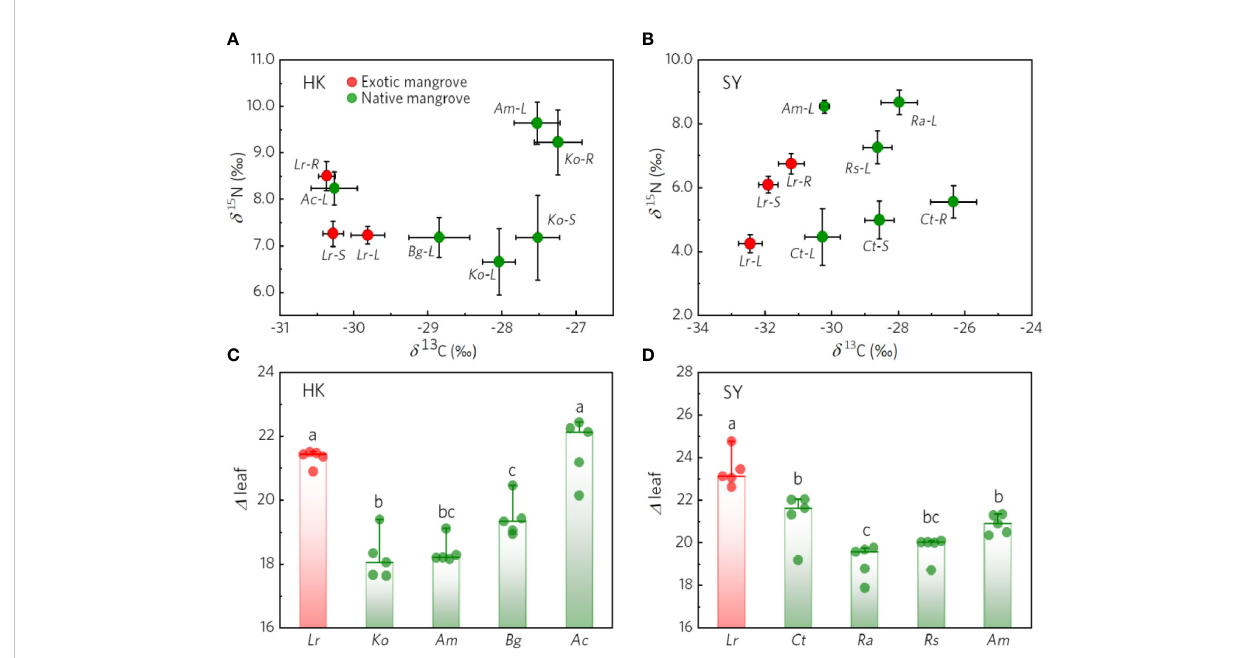
FIGURE 3 The value of d 13 C, d 15 N, and ⊿ leaf in native and exotic mangroves. Comparing mangrove d 13 C and d 15 N values of mangrove in HK(Haikou) site (A) and SY(Sanya) site (B) . The ⊿ leaf of mangrove in HK(Haikou) site (C) and SY(Sanya) site (D) . Exotic mangrove ( Lr - Laguncularia racemosa ) and native mangrove ( Ko - Kandelia obovata, Am - Avicennia marina, Rs - Rhizophora stylosa , Ct - Ceriops tagal , Bg - Bruguiera gymnorhiza , Ac - Aegiceras corniculatum,Ra- Rhizophora apiculata ), the error bars represent Mean ± SE (n=5). Red dots represent exotic mangroves, green dots represent native mangroves. The letters above the bar indicate different signi fi cantly (p<0.05).L, Leaf; S, Stem; R, Root.